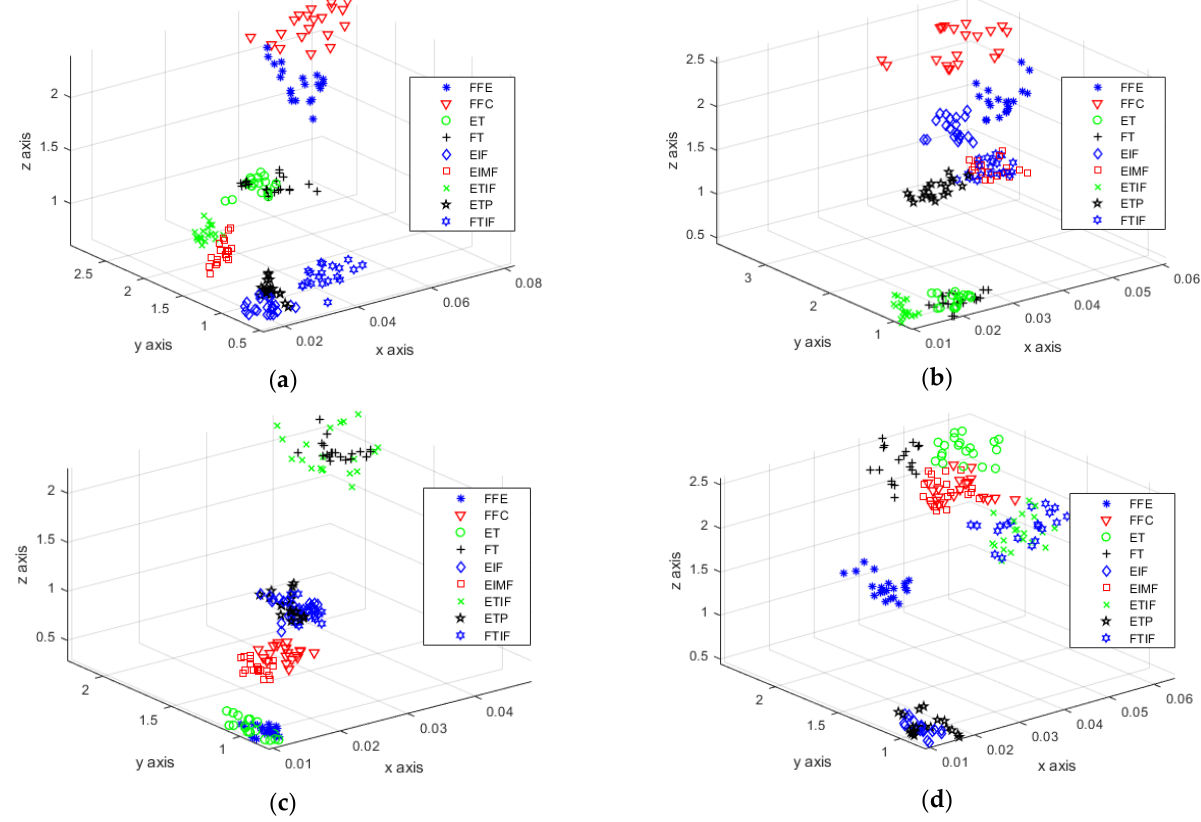
Figure 11. Multiscale singular value PE eigenvalue: ( a ) eigenvalue of ECR; ( b ) eigenvalue of ED; ( c ) eigenvalue of FDS; and ( d ) eigenvalue of EPB.